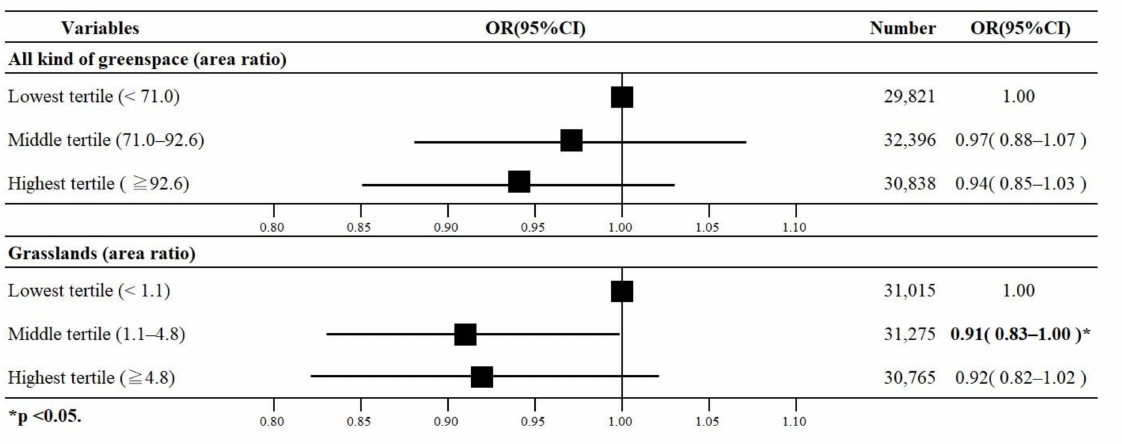
Figure 6. Odds ratios (ORs) with 95% confidence intervals (95% CI) for the association of all kinds of greenspace and grasslands with depression among older adults in rural areas ( n =